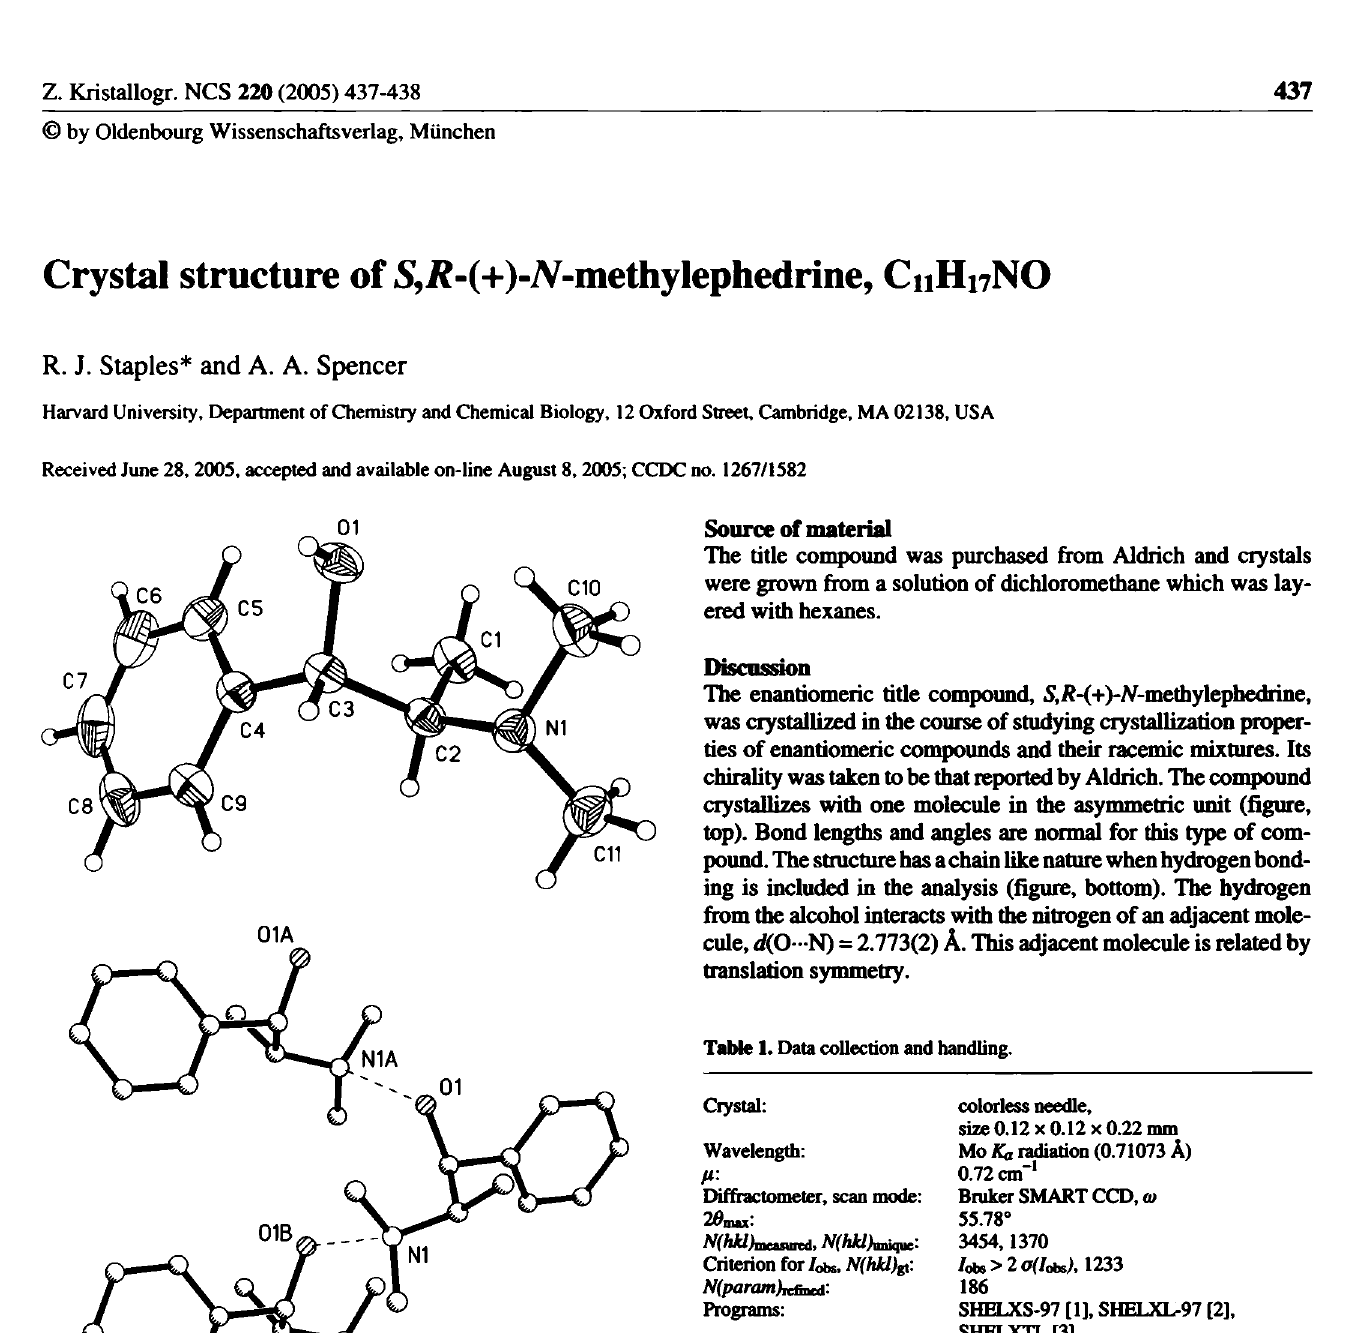
Table 2. Atomic coordinates and displacement parameters (in A 2